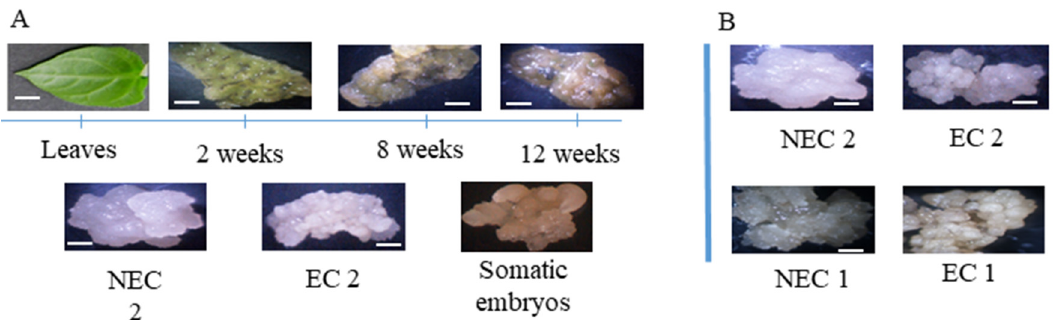
Figure 1. Plant material. ( A ) Time course of leaf explant SE induction; leaves from in vitro established plantlets were used. EC 2 and NEC 2 are the embryogenic and non-embryogenic calli resulting from the induction process. ( B ) EC 2 and NEC 2 were previously established from zygotic embryos and used in the IAA quantifications. The bars in each figure represent 1 mm with exception of the leaves in which the length is 1 cm.